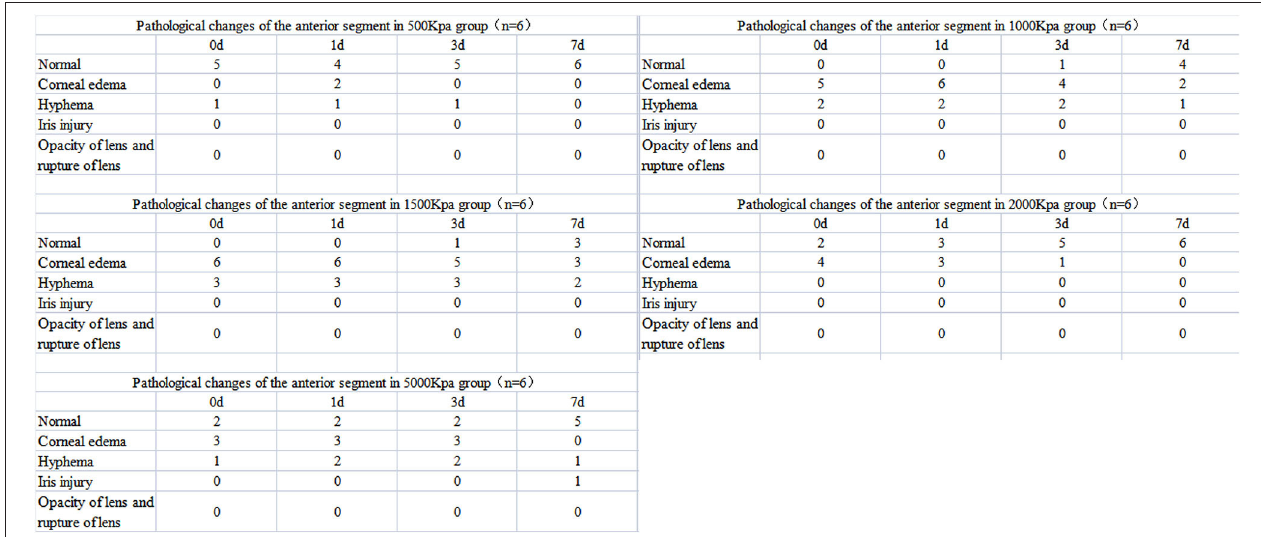
FIGURE 3 | Summary of pathological changes of anterior segment in eyes exposed to all pressure.